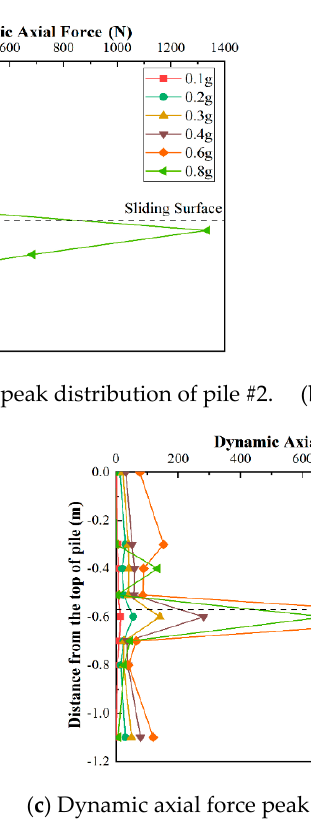
Figure 17. Dynamic axial force distribution for each row of piles (shaking table test).